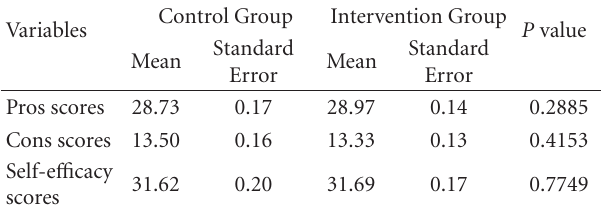
Table 3: Comparability between the intervention and control groups regarding decisional balance for benefits (“pros” scores) and barriers (“cons” scores) and self-e ffi cacy, adjusted for sex and age, after the proposed intervention (analysis of covariance,